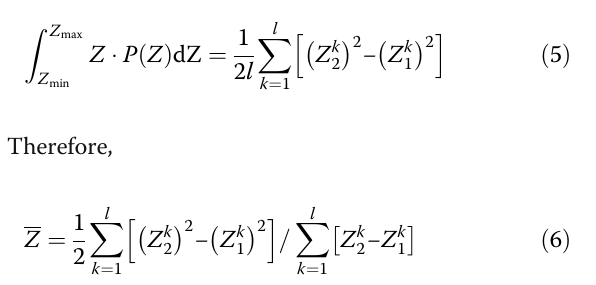
Table 2 The safety index system in the inland channel